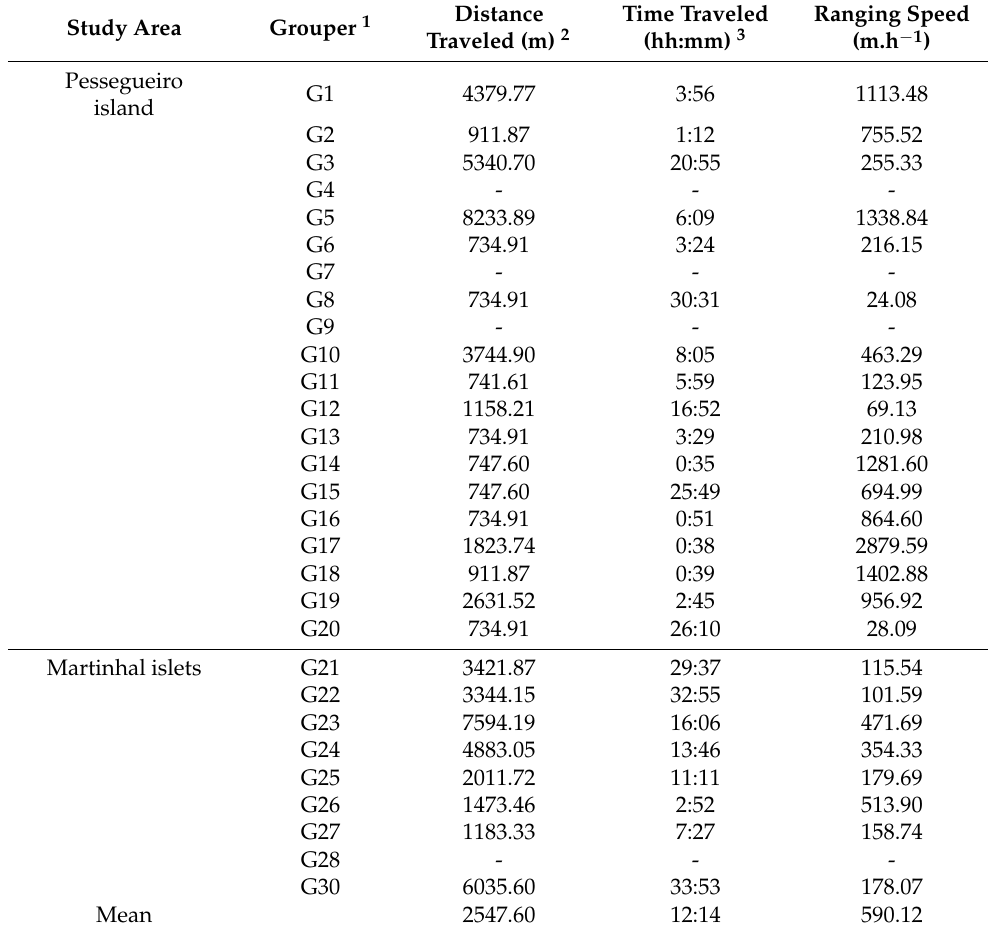
Table 5. Estimated short-distance ranging movements’ speeds based on minimum distances and time traveled by each dusky grouper in the Pessegueiro island and Martinhal Islets study areas. Study